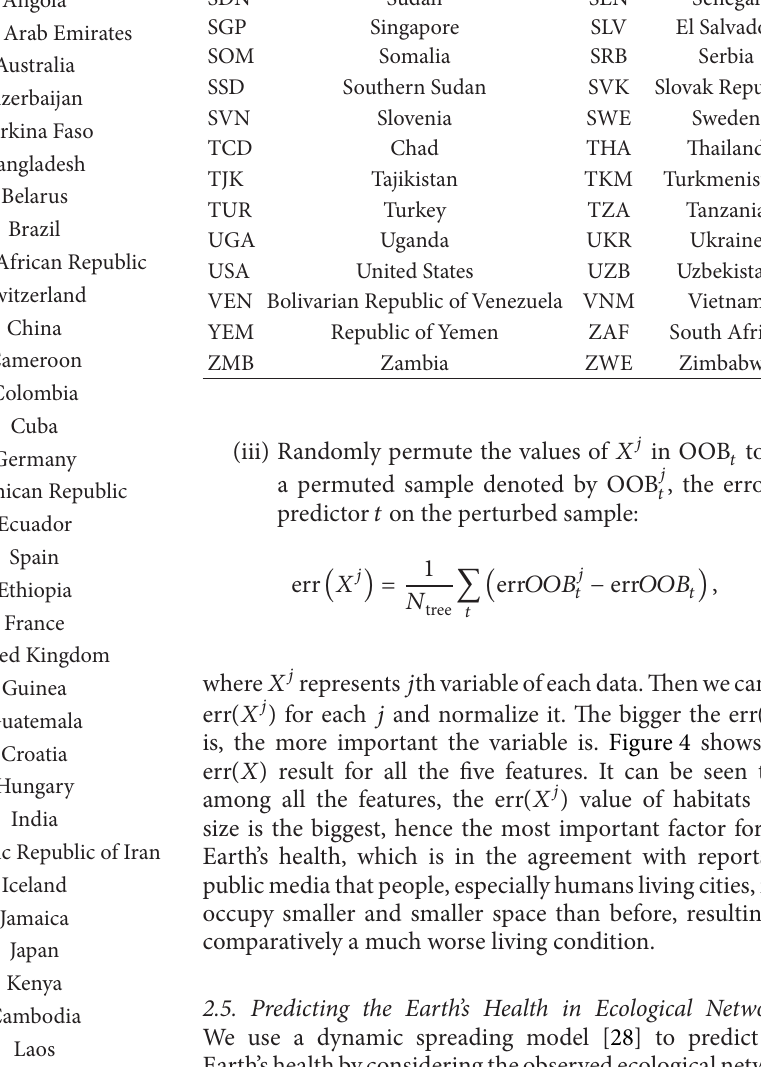
Table 4: Abbreviations of nation nodes.